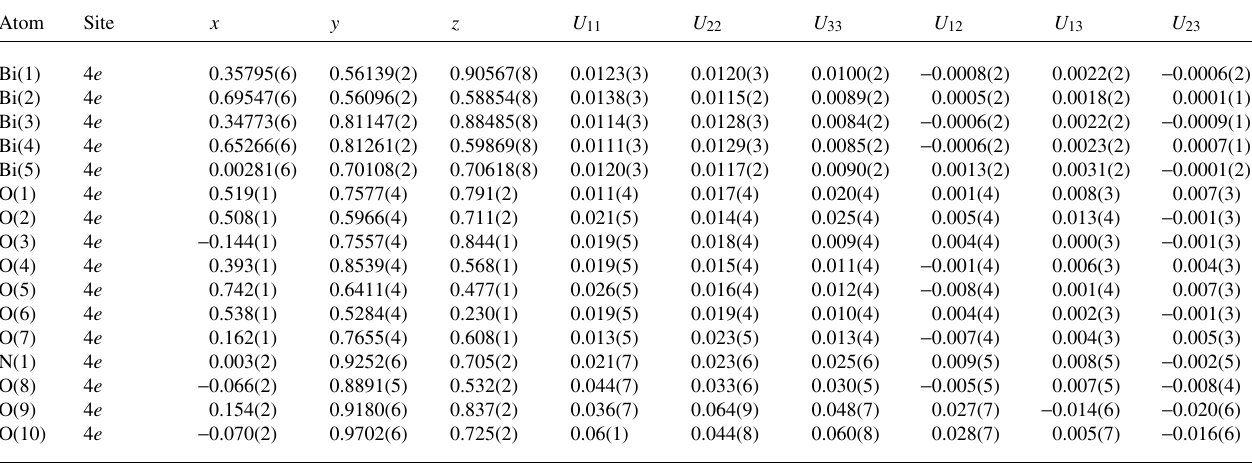
Table 2. Atomic coordinates and displacement parameters (in Å 2 )